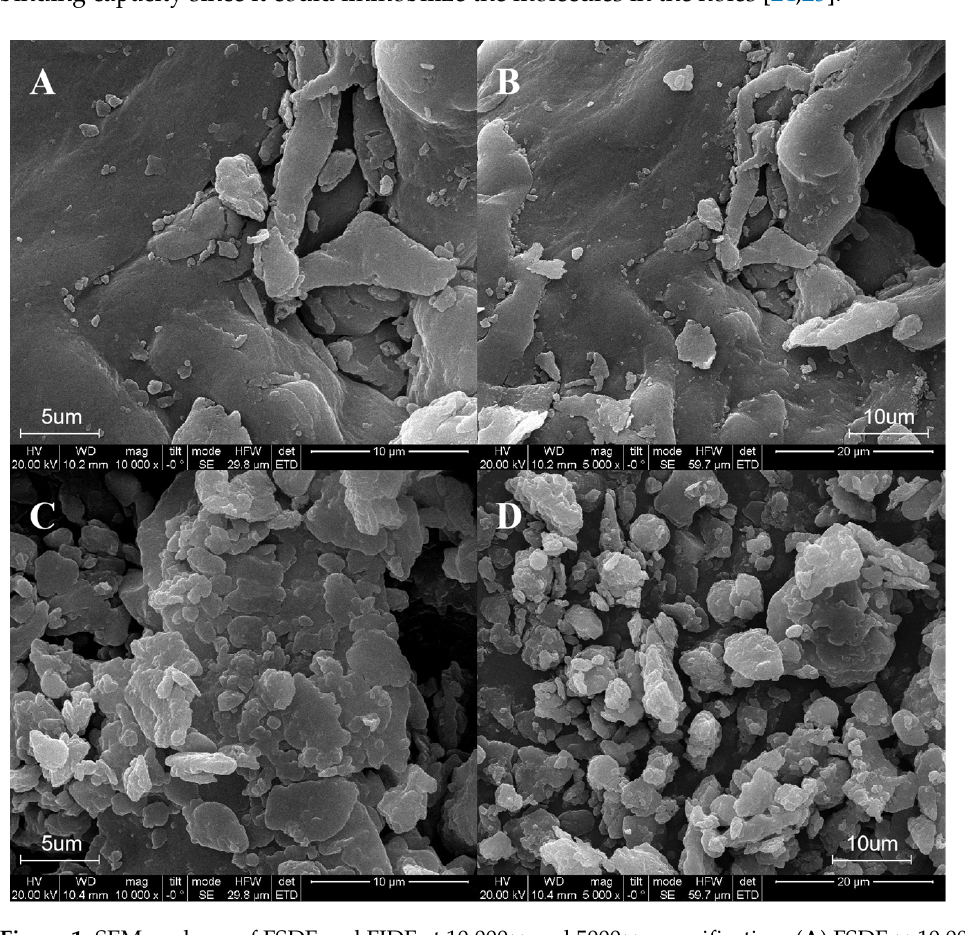
Table 1. The monosaccharide compositions (%) of FIDF and FSDF extracted from flaxseed cake. Data are expressed as mean ± SEM from three independent experiments.